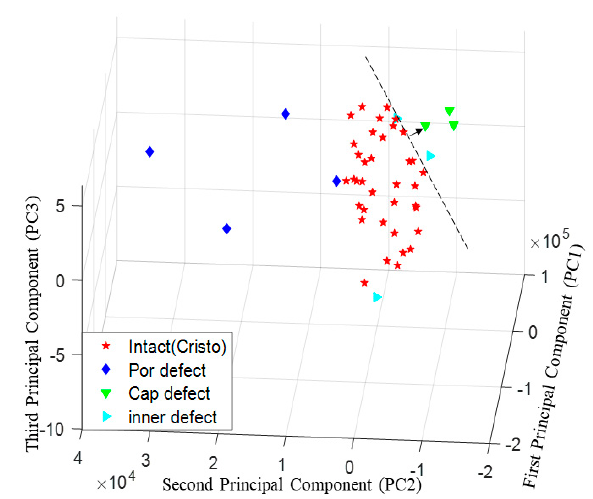
Figure 14. Three-dimensional plot using three eigenvectors extracted from frequency response data.